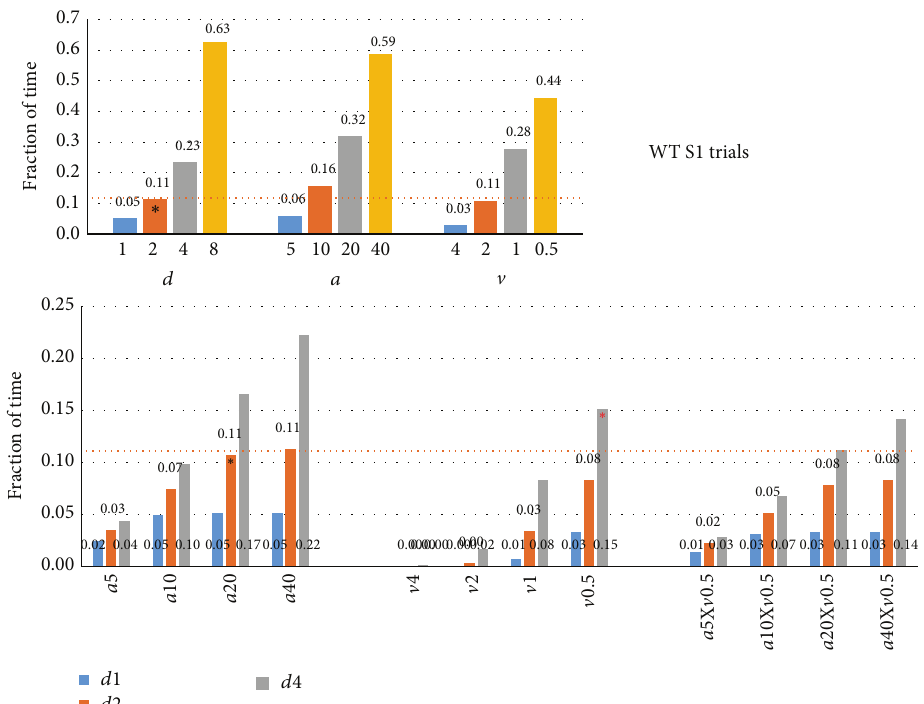
Figure 10: Exploration times at targeted criterion thresholds. Top: exploration time (as fraction of total trial time) was established for nose to odor source distance ( 𝑑 , < 1, < 2, < 4, and < 8 cm), head angle to odor source ( 𝑎 , < 5, < 10, < 20, and < 40 ∘ ), and velocity ( V , > 4, > 2, > 1, and > 0.5 cm/s) criteria at four threshold levels using population vectors (top) for S1 trials in WT mice ( 𝑛 = 7 ). Marked ( ∗ ) is 𝑑 2 (distance < 2 cm) as standard criterion reference, yielding 11% (13.2sec) exploration time. Relaxed criteria yield higher exploration times. Bottom: the effects of head angle and velocity criteria, separately ( a 5– a 40, v 4– v 0.5) or combined ( a 5– a 40 combined with v 0.5) on exploration time using a nose to odor source distance < 1, < 2, or < 4cm ( d 1– d 4) as additional criterion in each graph. Marked ( ∗ , black) is the combined criterion 𝑎 < 20 ∘ and 𝑑 < 2 cm, being the commonly used “standard” criterion, which did not restrict the exploration time over criterion 𝑑 < 2 cm alone ( d 2, Top). Also marked ( ∗ , red) is the combination 𝑑 < 4 cm and V > 0.5 cm ( d 4- v 0.5), suggested as useful new criterion (see Results and Figure 11) that yielded 15% exploration